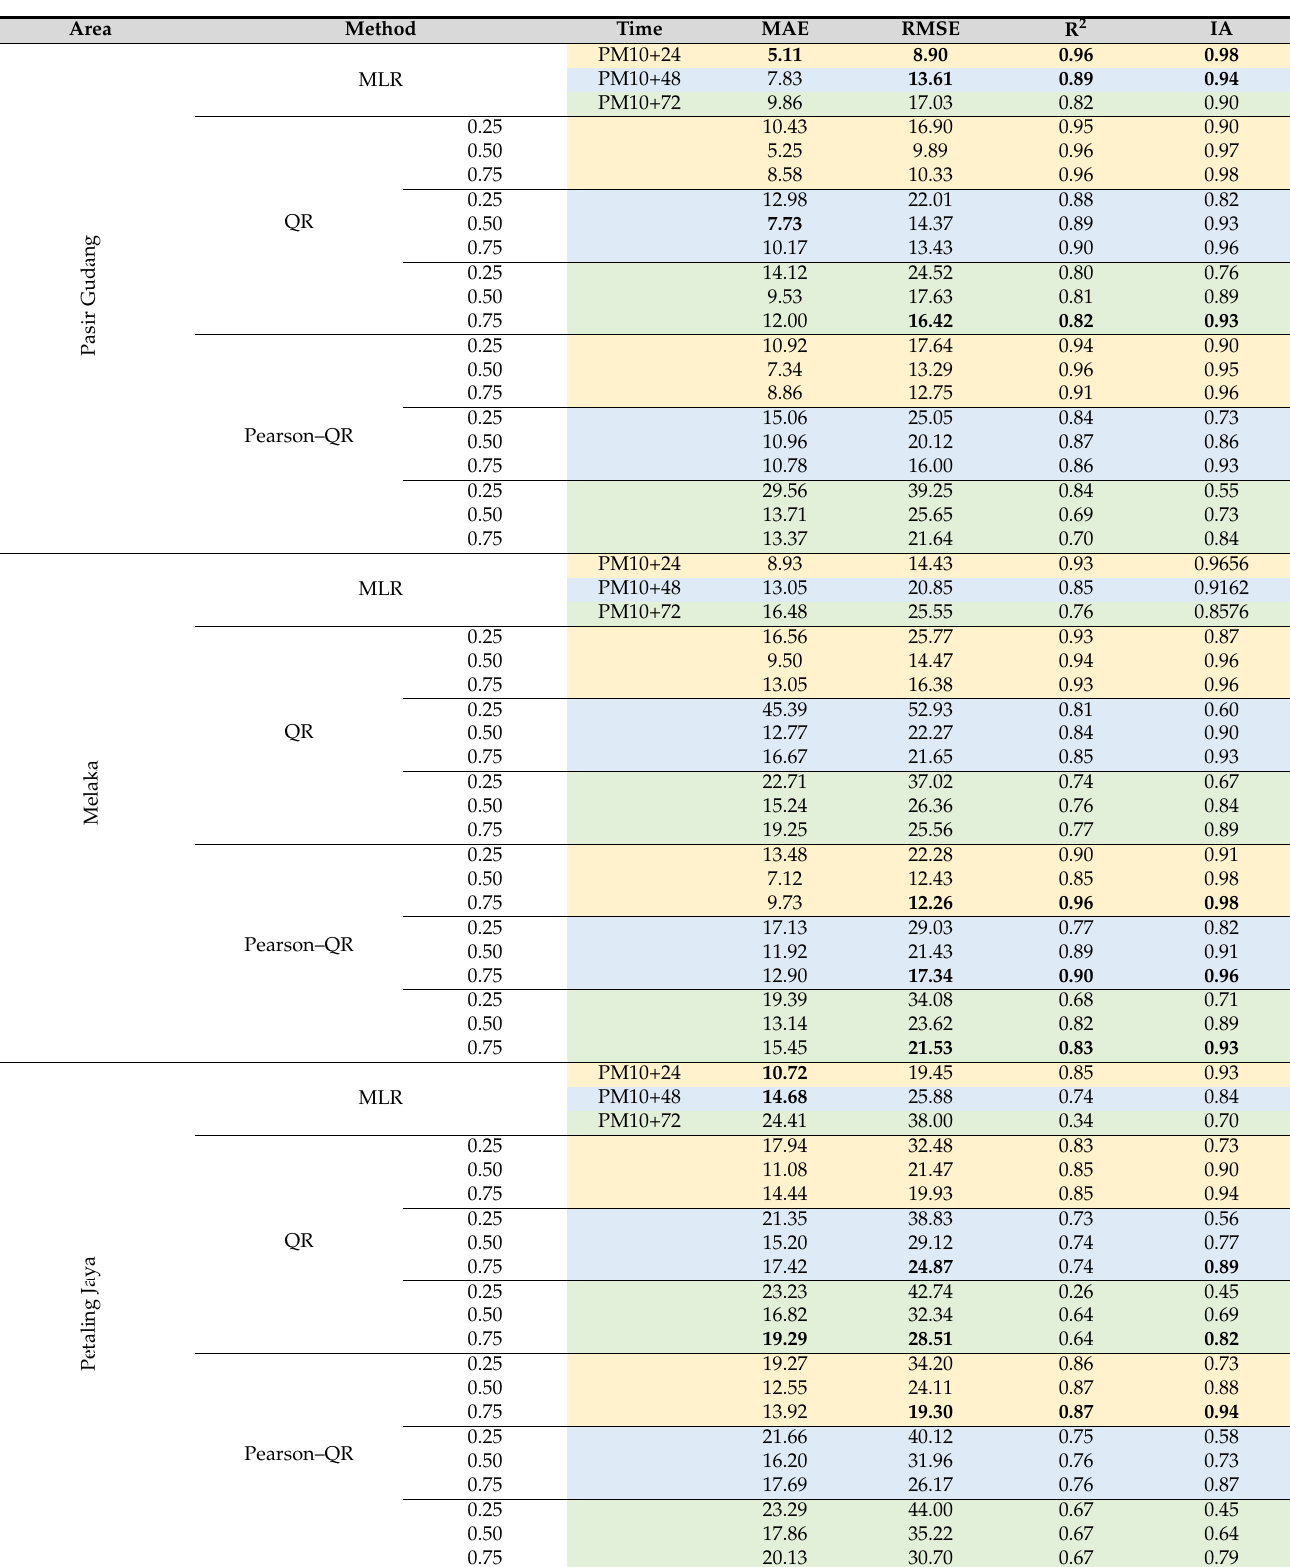
Table 8. Performance indicator values for the predicted PM10 levels. The cream color represents the next-day prediction (PM10+24); blue represents the next two-day prediction (PM10+48); green represents the next three-day prediction